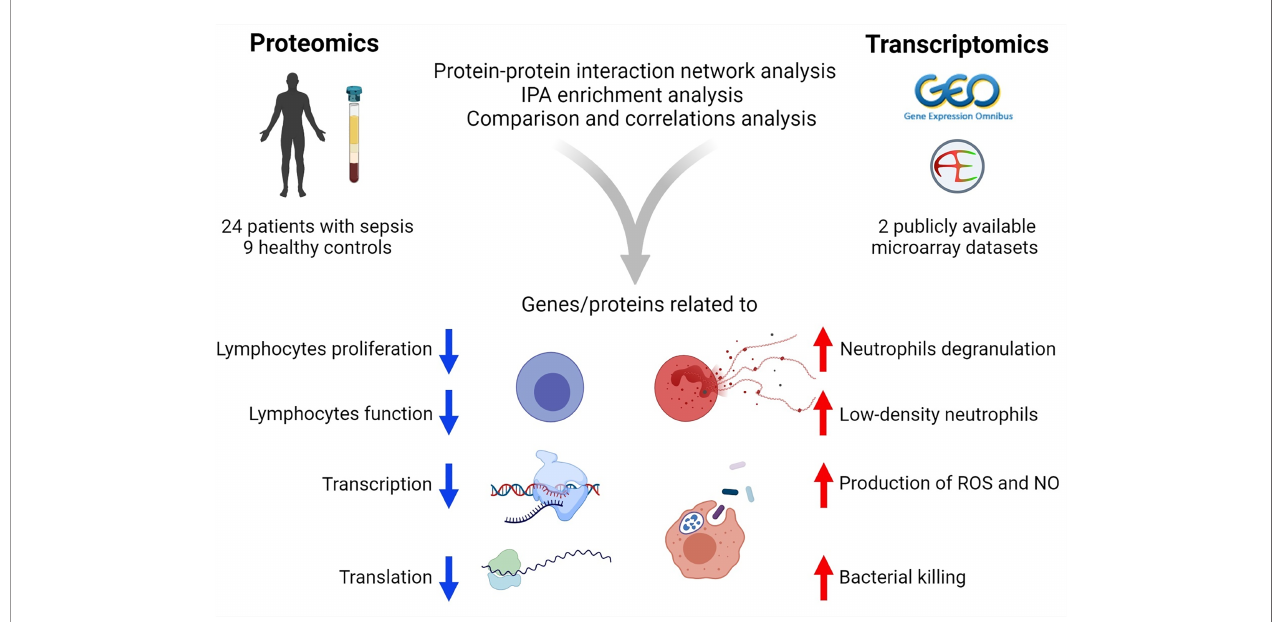
FIGURE 7 | Summary of the results of transcriptomics and proteomics pro fi ling of septic